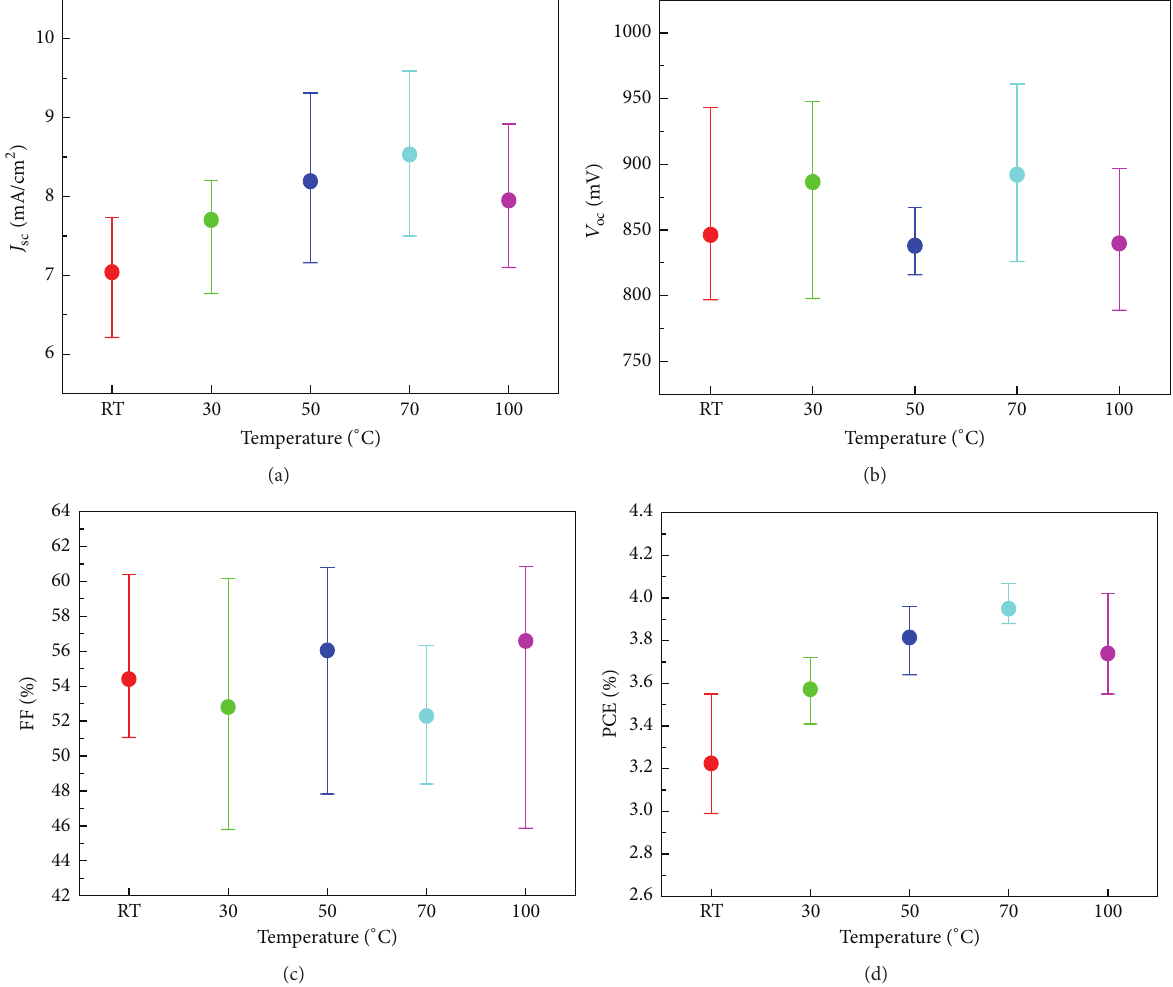
Figure 1: 𝐽 - 𝑉 characteristics of MPSCs based on MAPbI 3 perovskite thin films depending on the different preheating substrate, before spin-coating PbI 2 solution: (a) short circuit current density ( 𝐽 sc ), (b) open circuit voltage ( 𝑉 oc ), (c) fill factor (FF), and (d) power conversion efficiency (PCE).